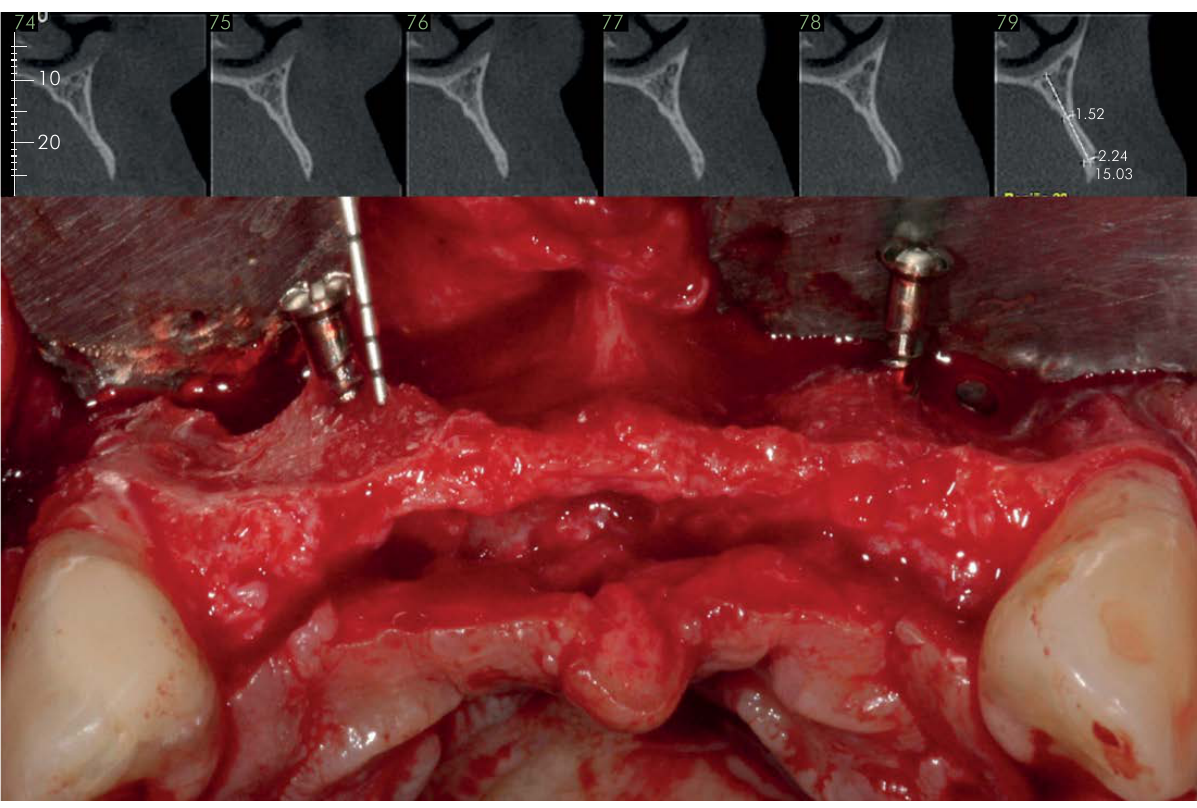
Figure 2. Preoperative tomographic view (parasagittal plane) and clinical view 6 months after horizontal augmentation with osteoconductive material. CT showing significant thickness bone loss and absence of cancellous bone between the buccal and palatal cortical bone plates in most of the alveolar bone (HAC